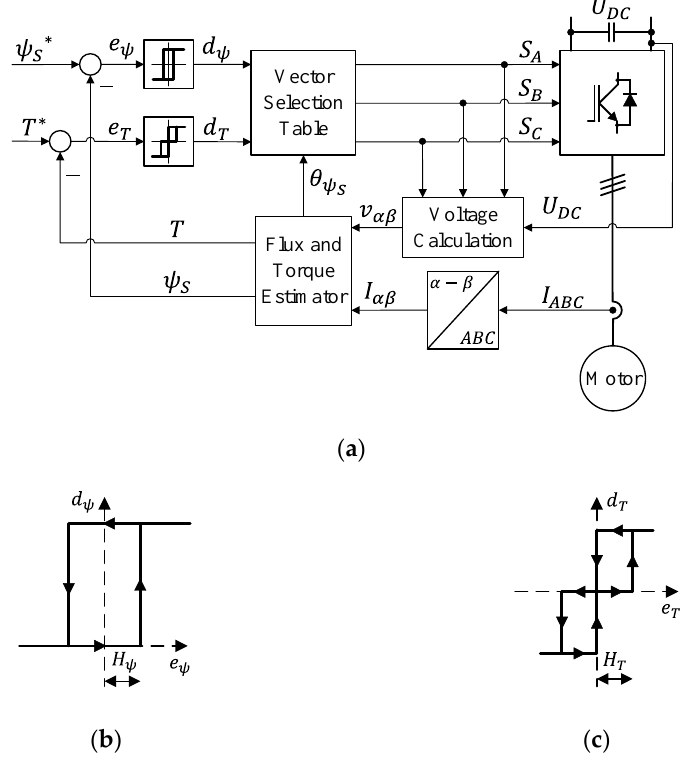
Figure 1. Conventional DTC principle: ( a ) control scheme; ( b ) flux hysteretic cycle; ( c ) torque hysteretic cycle.